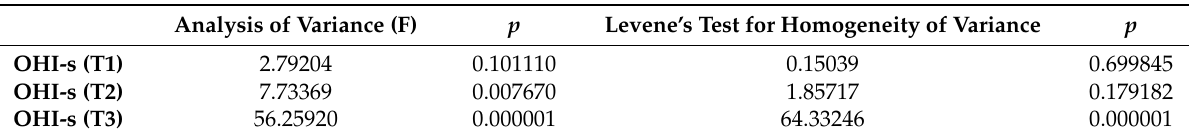
Table 4. Analysis of homogeneity of variance for